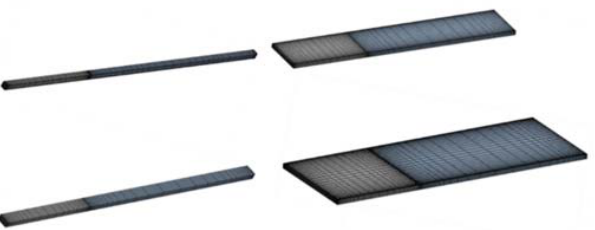
Figure 2. Examples of meshes for 3D geometries with aspect ratios: ( top left ): 1:1; ( bottom left ) 2:1; ( top right ) 10:1; ( bottom right ) 20:1; In the present work top right.